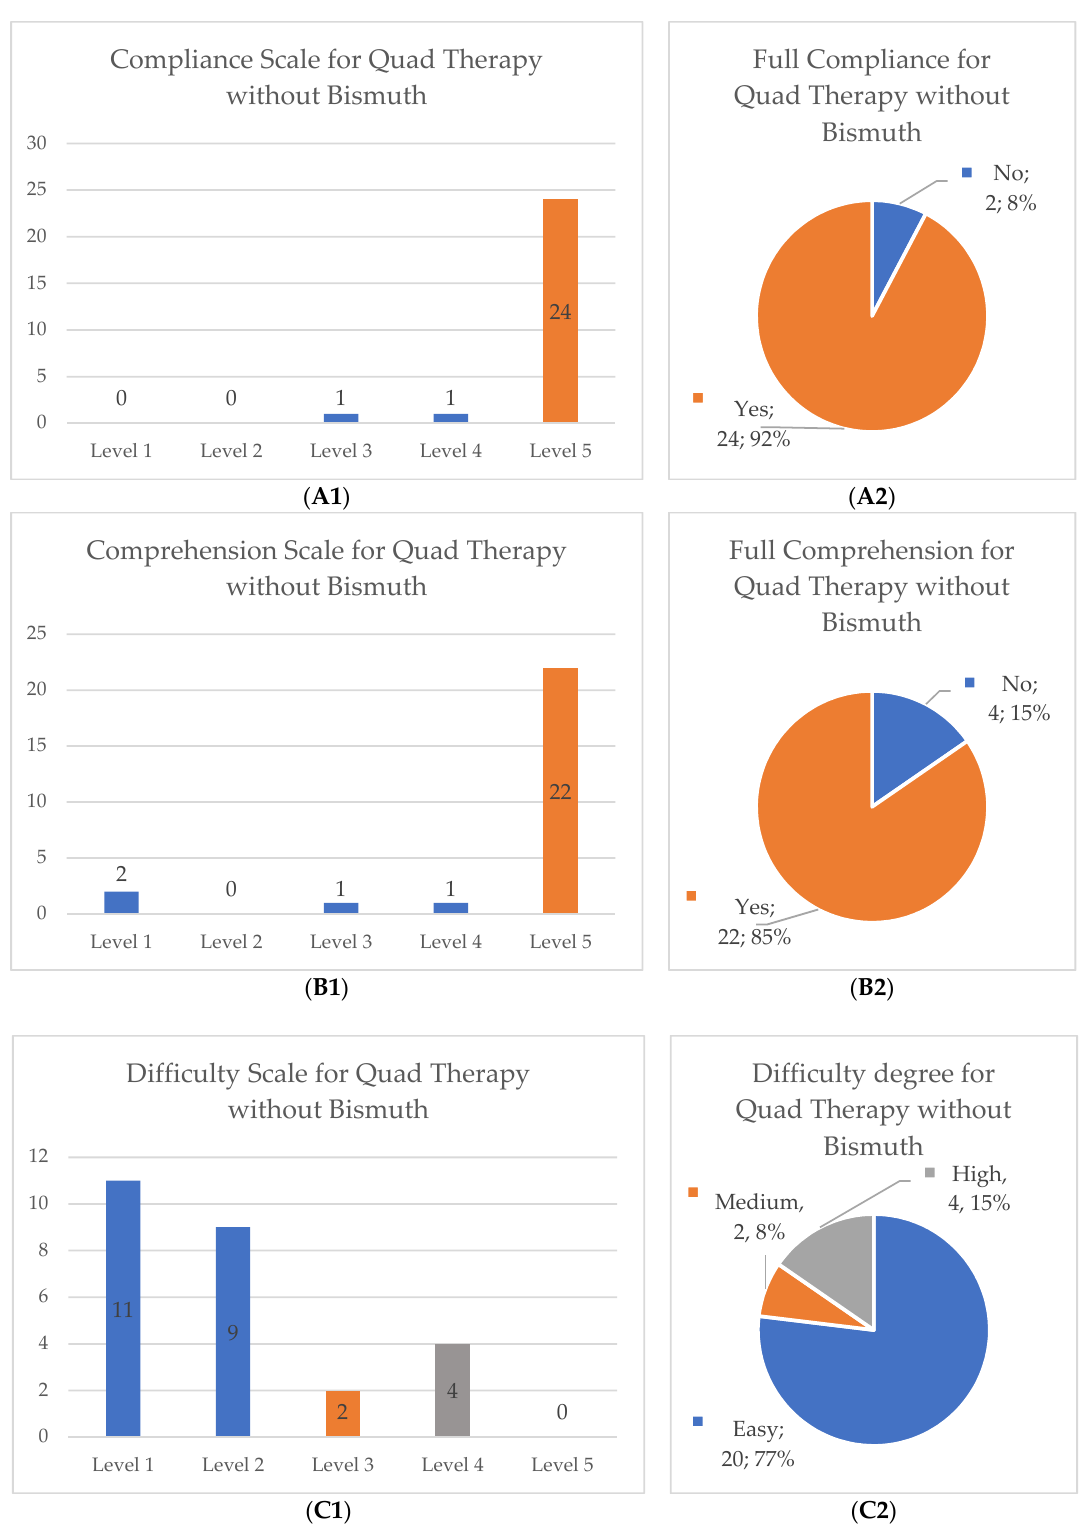
Figure 1. Distribution of data collected from compliance, comprehension and difficulty in Quadruple Therapy without Bismuth: the original scales ( A1 , B1 , C1 ) and the new categorical organization of data ( A2 , B2 , C2 ). Levels 1 to 5 represent a categorical scale used by the authors (a higher level corresponds to higher/full compliance, higher comprehension of prescribed posology of treatment and higher difficulty felt in completing the scheme).